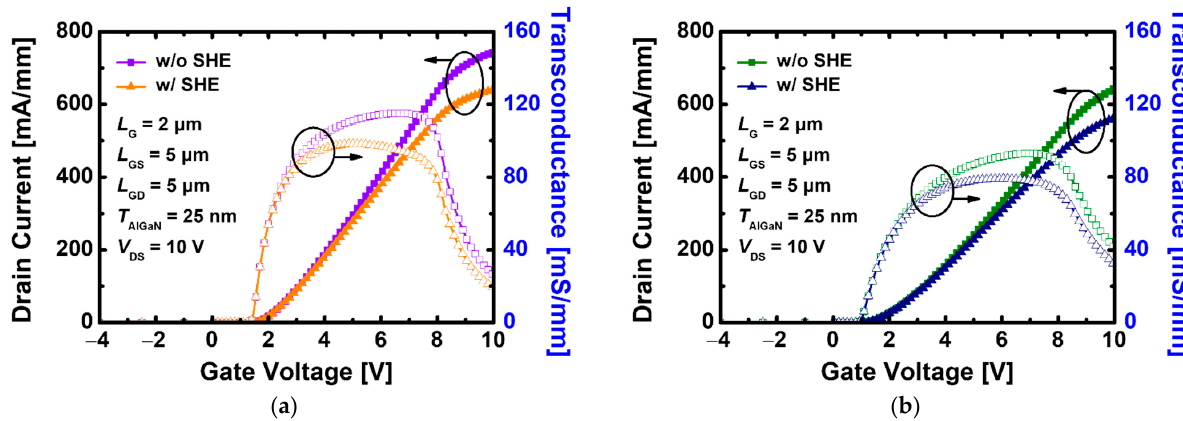
Figure 11. I D - V G transfer characteristics with and without SHE in recessed-gate GaN MOSFET on SiC using ( a ) the stacked TiO 2 /Si 3 N 4 dual-layer insulator, ( b ) Si 3 N 4 single-layer insulator at V DS = 10 V.